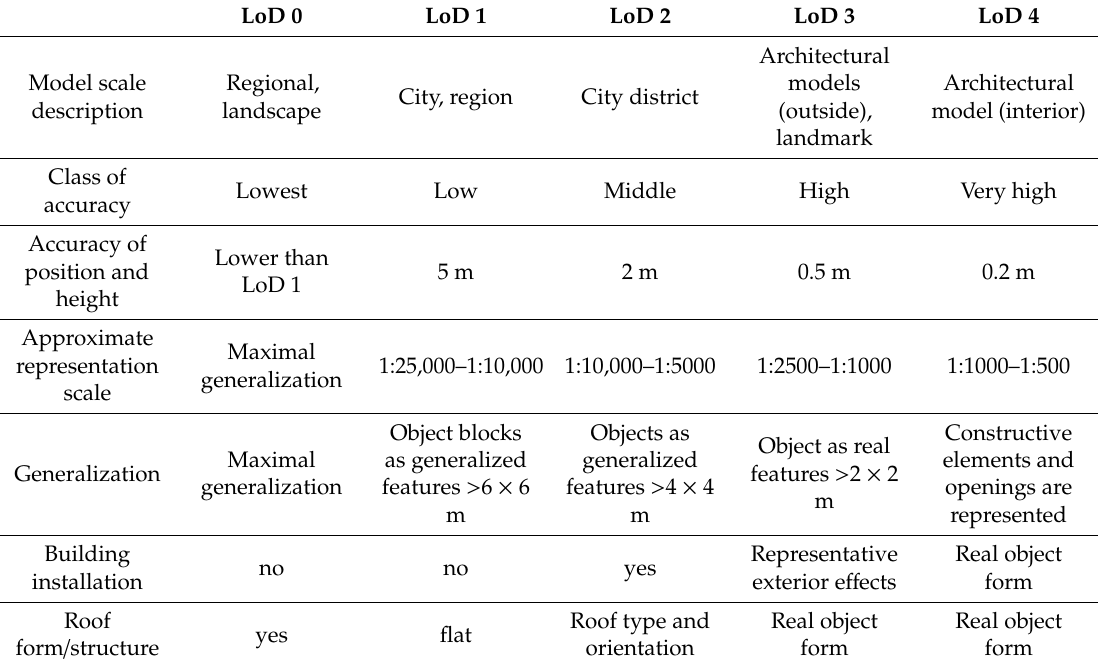
Table 1. Characterisitics of levels of detail 0–4 representations in CityGML—buildings